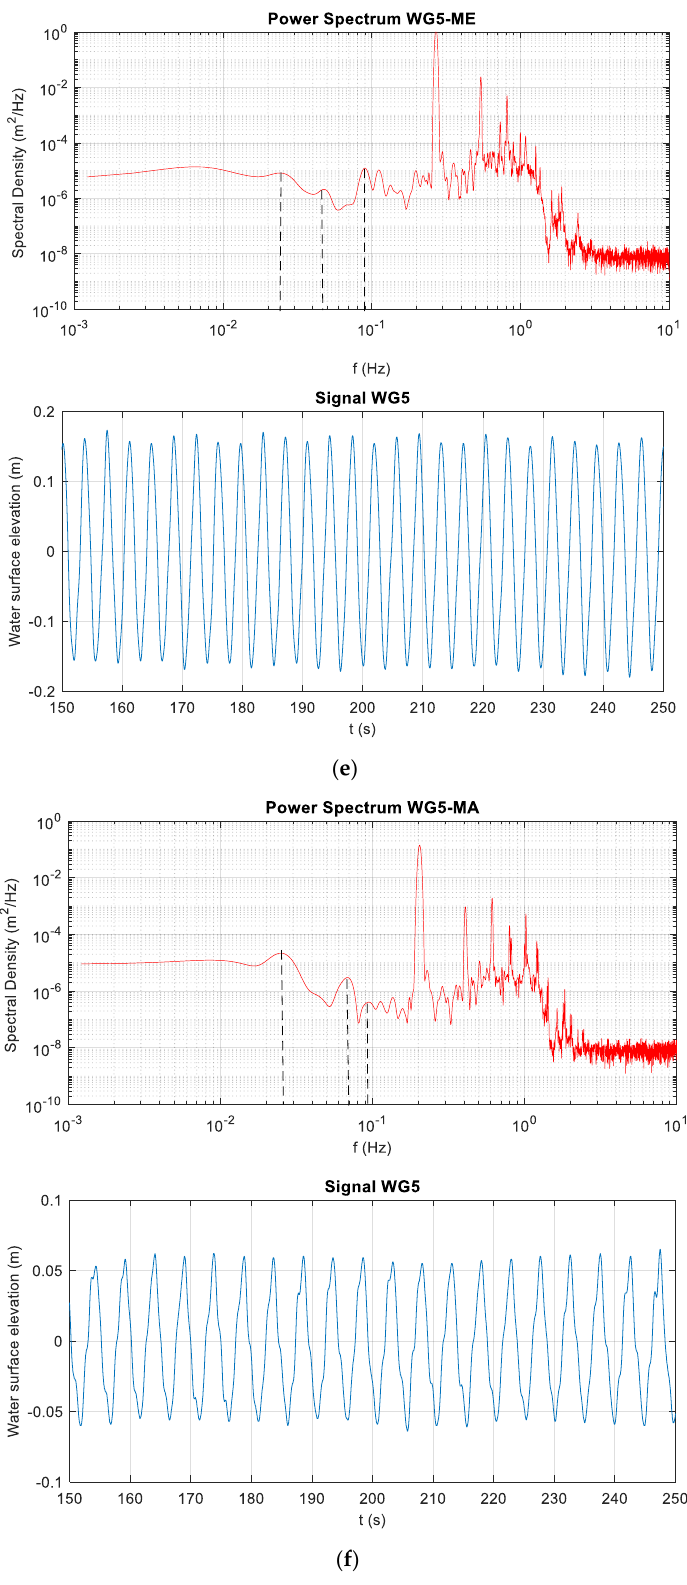
Figure 4. Power spectral density and time series water surface elevation for test: ( a ) BE_1; ( b ) BE_2; ( c ) BA_1; ( d ) BA_2; ( e ) ME; and ( f ) MA. Dashed black lines show the peaks in the low frequencies range used in the present analysis. Table 3. Peak frequencies, periods and power spectral density for BE_1 and BE_2 tests.